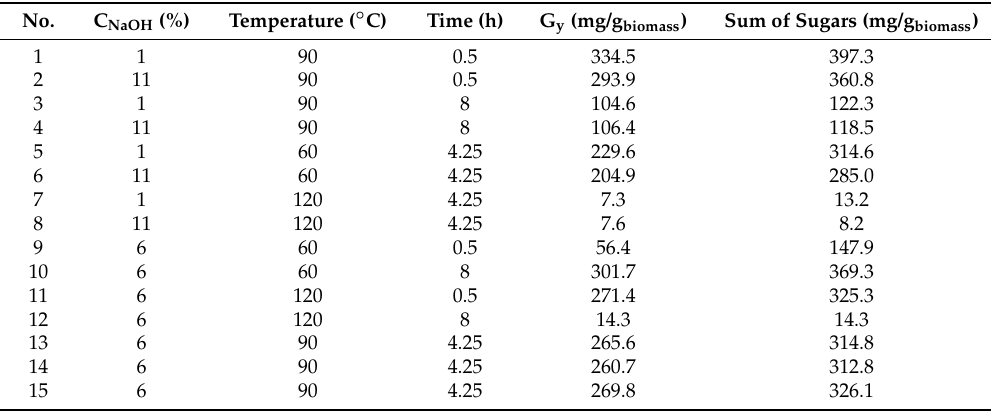
Table 3. Box-Behnken design for alkaline pre-treatment and acid hydrolysis of Triticum sp.